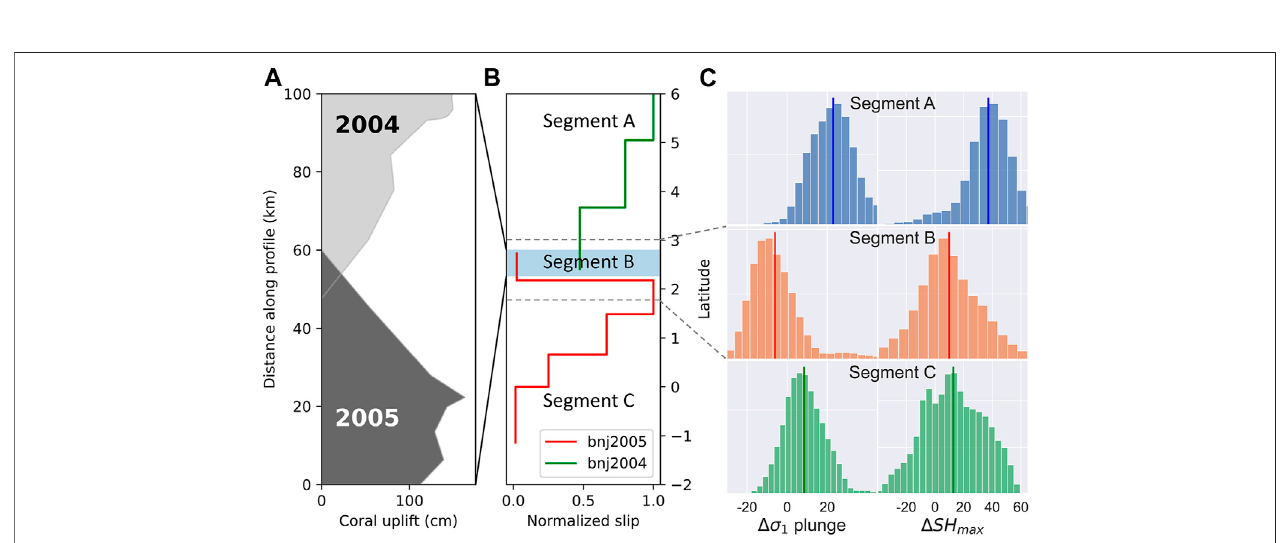
FIGURE10| Comparison of (A) coseismic upliftdatafrom Coralmicroatollson thecoast ofSimeulue(Briggs etal., 2006)measuredbefore and after the2004and 2005 earthquakes with (B) pro fi les of normalized slip (maximum slip as a function of latitude divided by the maximum slip for the respective event, taken from the fi nite fault models of Banerjee et al., 2007), and (C) distributions for changes in the pre-vs post-mainshock changes in the plunge of σ 1 and azimuth SH max among the outer forearc segments A, B and C.